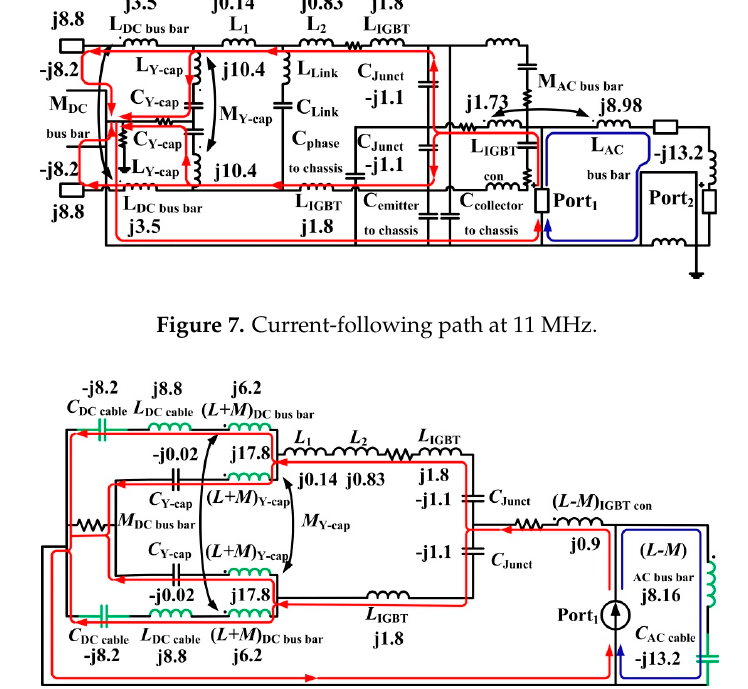
Figure 8. Equivalent circuit at 11 MHz.